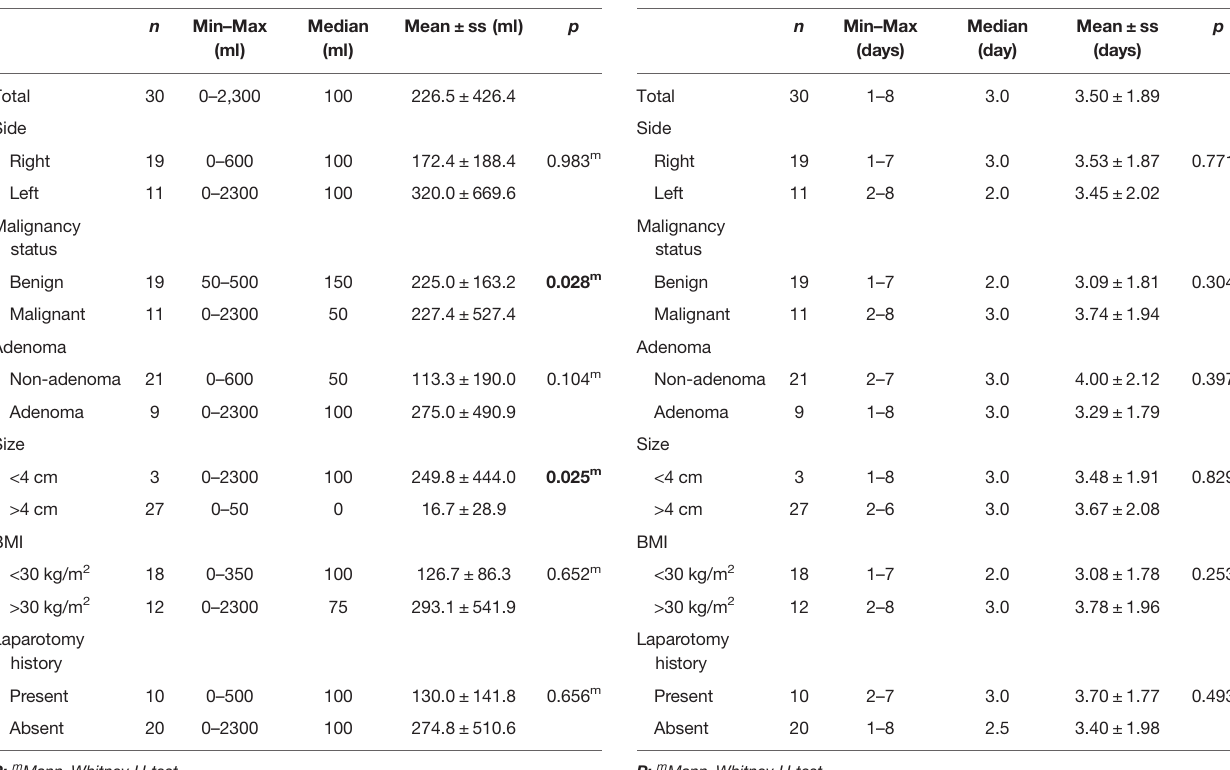
TABLE 4 | Bleeding amount (ml) during surgery according to the analyzed criteria.